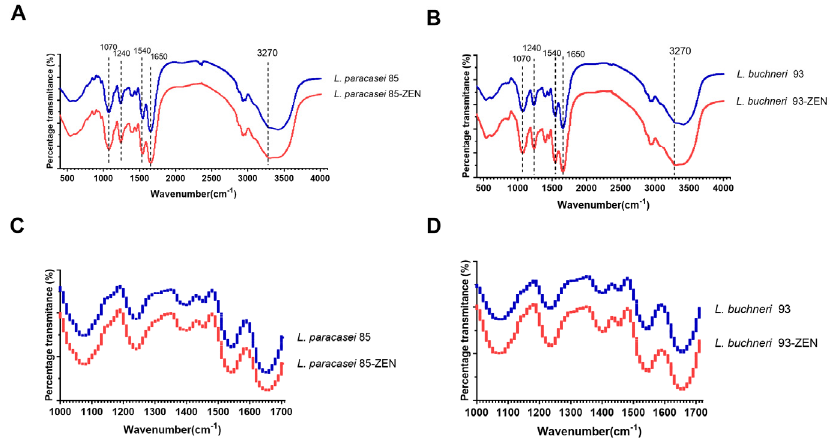
Figure 6. FTIR spectra of L. paracasei 85 and L. buchneri 93 with or without ZEN incubation. The FTIR spectra of L. paracasei 85 in ( A ) (400–4000 cm − 1 ) and ( B ) (1000–1700 cm − 1 ). The FTIR spectra of L. buchneri 93 in ( C ) (400–4000 cm − 1 ) and ( D ) (1000–1700 cm − 1 ).